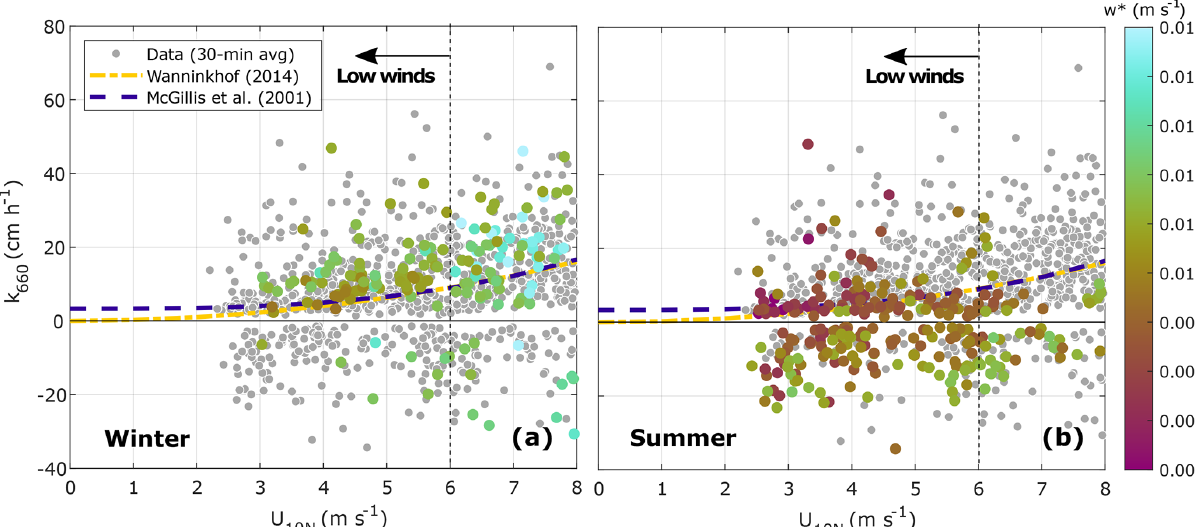
Figure 9. Gas transfer velocity for CO 2 (adjusted to a Schmidt number of 660) as a function of the 10m neutral wind speed during (a) winter and (b) summer. The dots represent the half-hourly values of k 660 . The colour represents the water-side convective scale ( w ∗ ) for data under unstable atmospheric conditions, calculated according to Rutgersson and Smedman (2010). The wind-speed regimes are separated by a vertical dashed line.